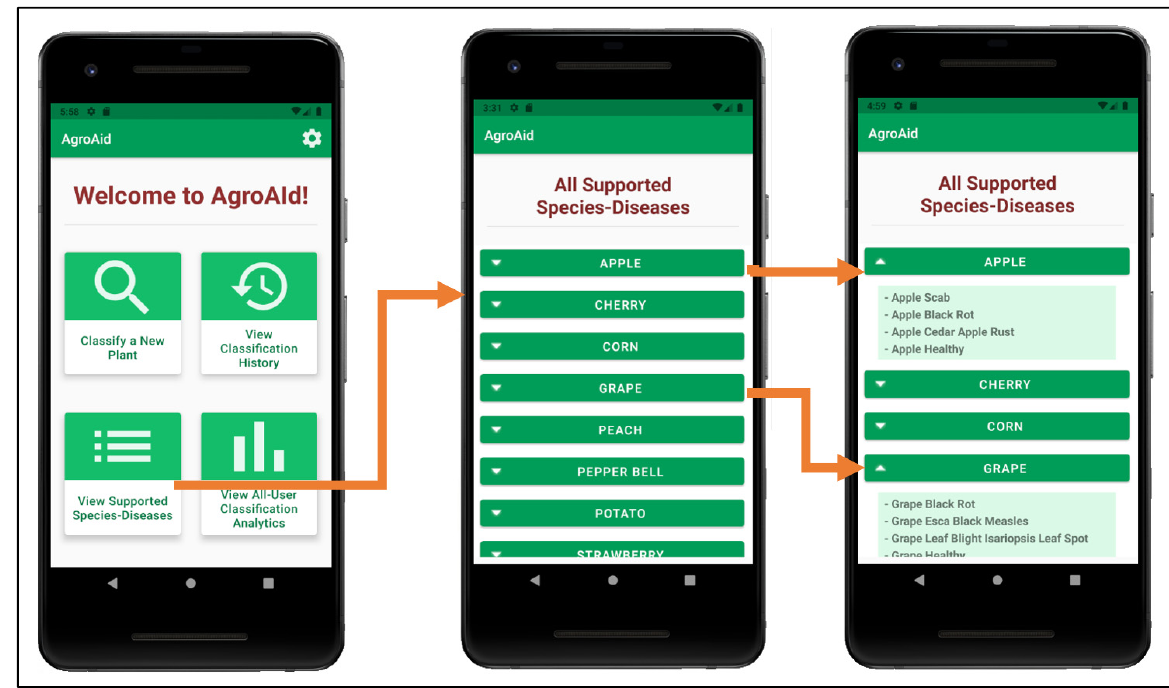
Figure 28. Viewing the list of all supported [ species–disease ] combinations and expanding the details of some of the species listed.